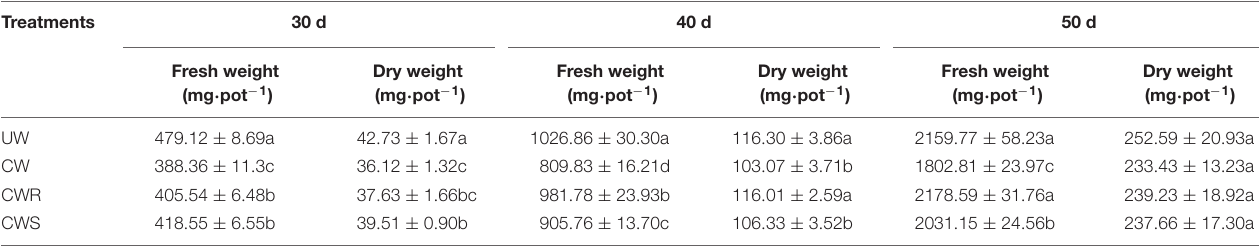
UW, uncontaminated soil planted with white clover; CW, contaminated soil planted with white clover; CWR, contaminated soil planted with white clover and inoculated with strain Phe15 via root irrigation; CWS, contaminated soil planted with white clover and inoculated with strain Phe15 via soaked seed. Different letters in the same column indicate significant differences (P <